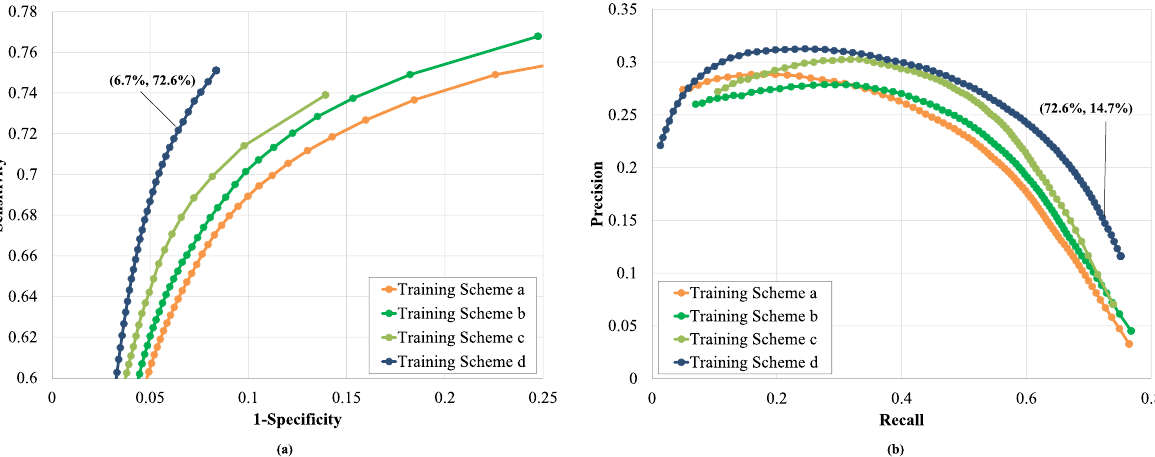
Fig. 2 The image-based performance of AI-doscopist on Dataset B under different training schemes. a the Receiver Operating Characteristic curves and b the Precision – Recall curves. In Training Scheme a, AI-doscopist learnt only the spatial features from a random subset of 33,819 original colonoscopy images. In Scheme b, the training set was enlarged to a random subset of 119,703 original colonoscopy and non-medical images. In Scheme c, AI-doscopist learnt both the spatial and temporal features from a random subset of 119,703 original colonoscopy and non-medical images. In Training Scheme d, the spatial and temporal features were learnt from a larger, random subset of 191,493 colonoscopy and non-medical images. A total of 34,469 images were used for validation in each